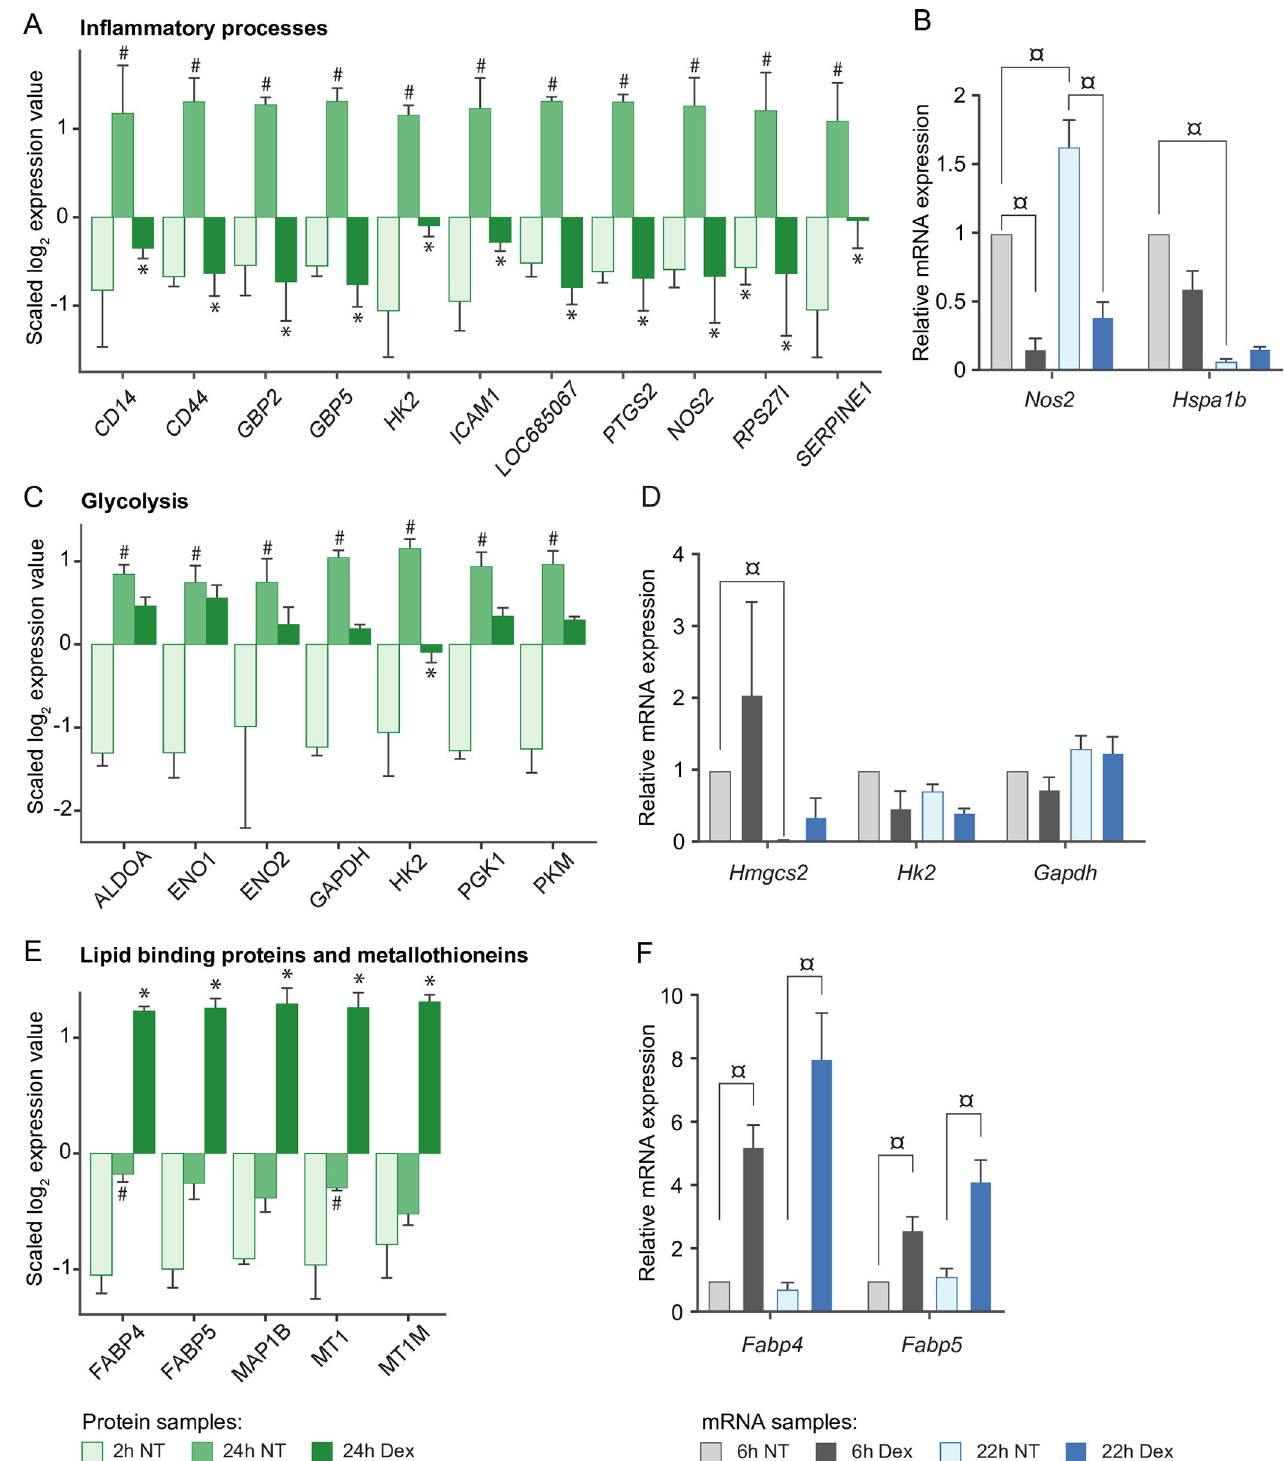
Fig 6. Differentially expressed proteins in selected processes affected by Dex in the cell-associated proteome of rat LSECs. Panels (A) and (C) show differentially expressed proteins contributing to the inflammatory-like phenotype (A), or glycolysis shift (C) in culture, while (E) shows the differential expression of lipid binding proteins (FABP4, FABP5), metallothioneins (MT1, MT1M), and microtubule-associated protein 1B (MAP1B). In panels (A), (C), and (E) the bars represent the Z-score value of the log 2 normalized TMT reporter intensities for each protein per time point and treatment. Results are average values of 3 biological replicates. Error bars show SD. # Significantly different between 24 h non-treated (NT) and 2 h NT cultures; � Significantly different